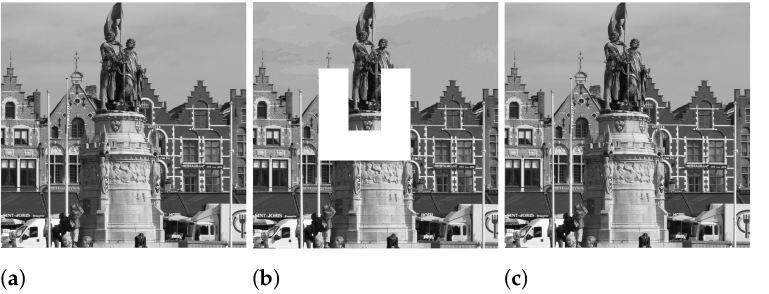
Figure 7. Example of image perfect restoration after a 10% attack. ( a ) Watermarked image, ( b ) attacked image, and ( c ) restored image.